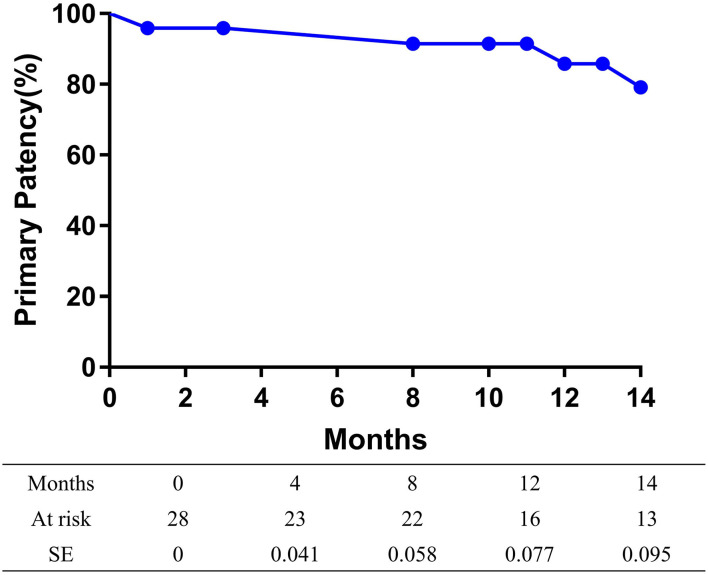
Kaplan-Meier curves of the primary patency of patients.